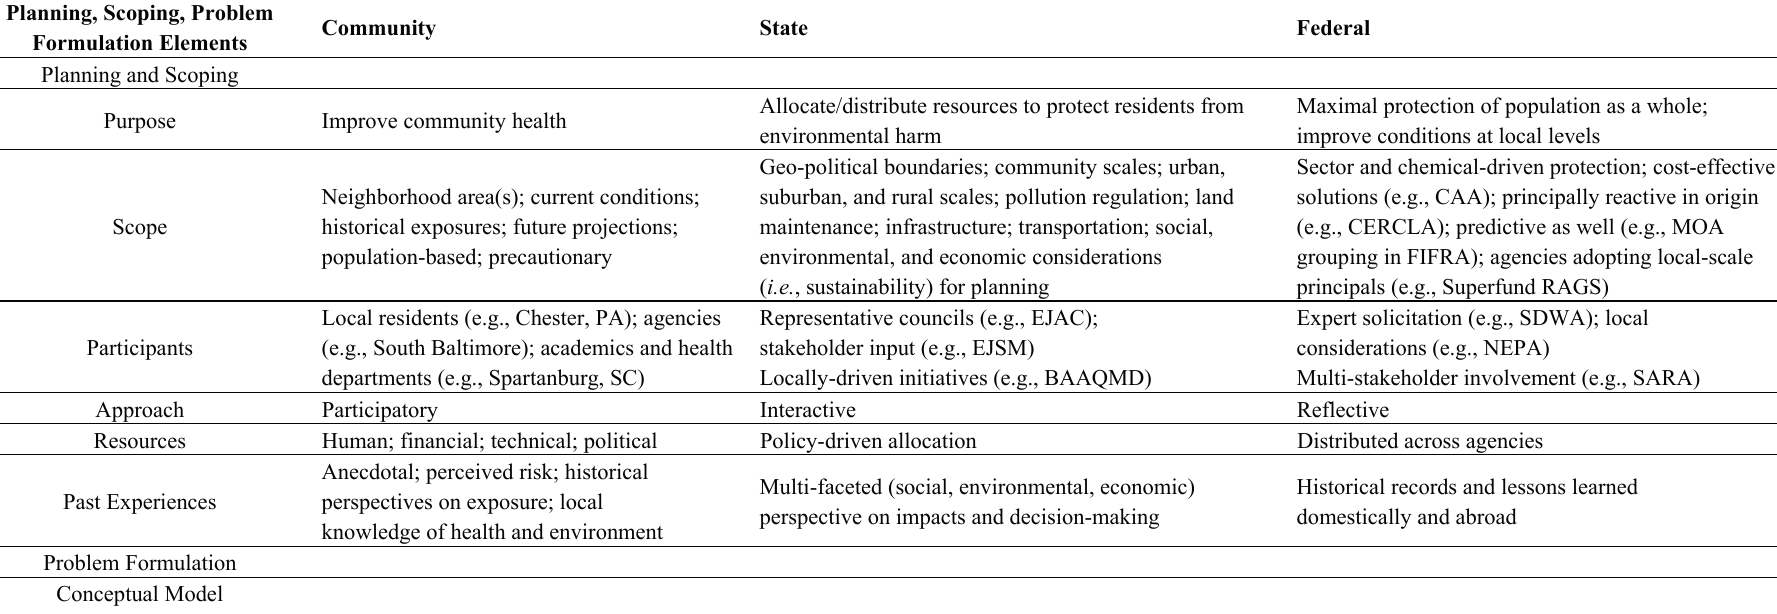
Table 2. Synopsis of Planning, Scoping, and Problem Formulation elements for Phase 1 of a CRA for Community, State, and Federal